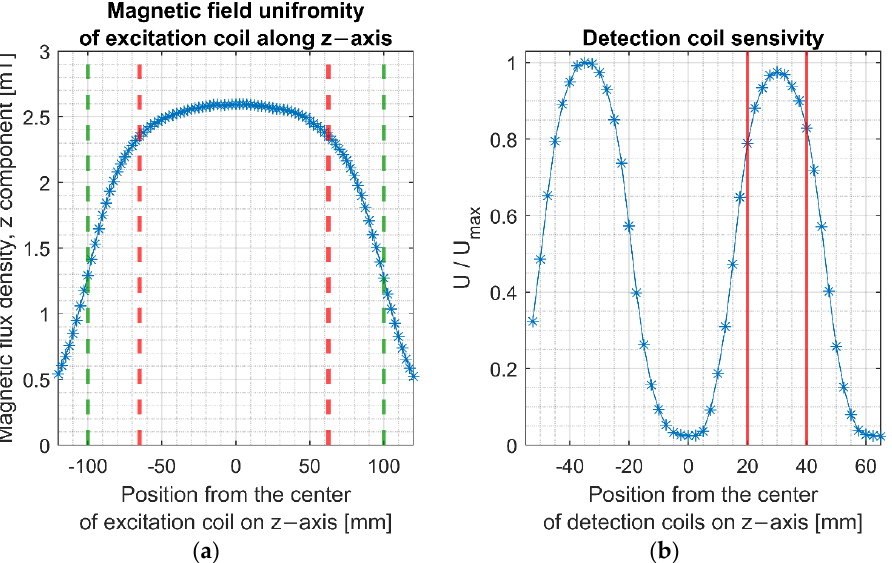
Figure 5. ( a ) Magnetic induction along the longitudinal axis of the excitation coil. Green dashed lines represent the physical ends of the coil, and the red dashed line shows a limited region inside the coil where the magnetic field varies less than 10% from the center point. ( b ) Relative spatial sensitivity along the longitudinal axis of two oppositely wound detection coils. The induced voltage was normalized to its maximum value. Red vertical lines show the position of a nanoparticle sample inside the detection coil.